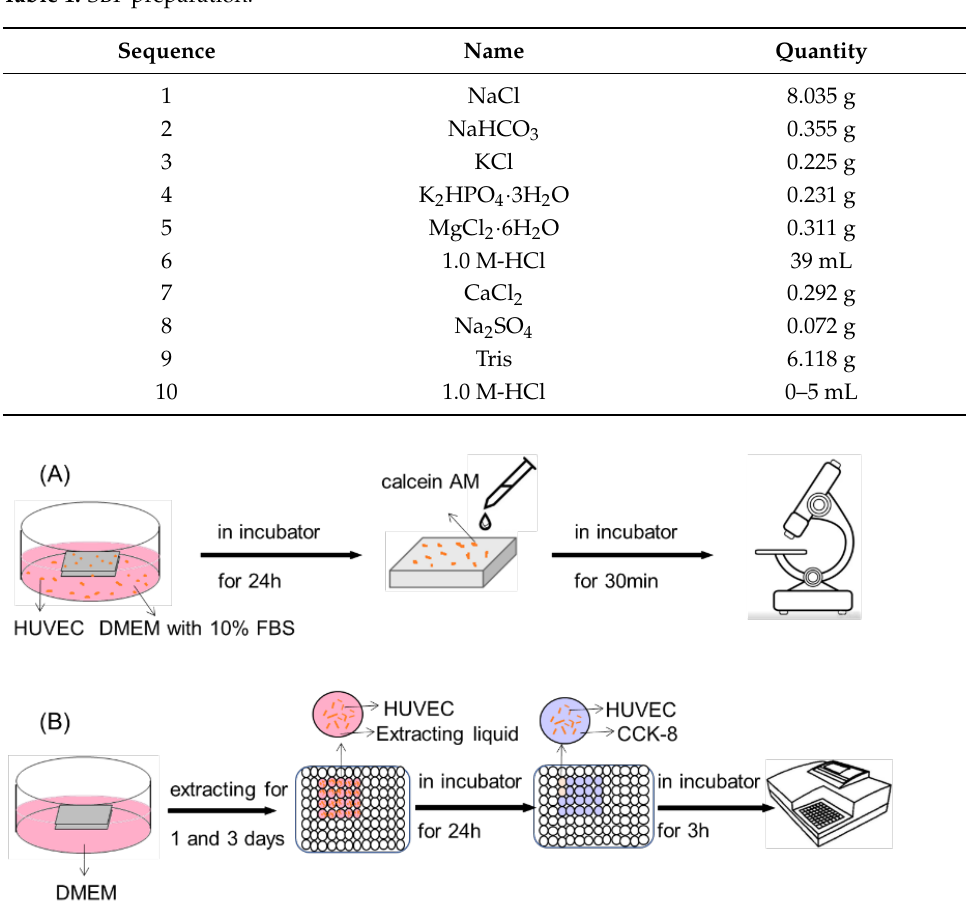
Figure 2. Cell testing of coated and bare Mg alloys ( A ) Processing of testing cell adhesion, ( B ) Pro- cessing of testing cell viability.